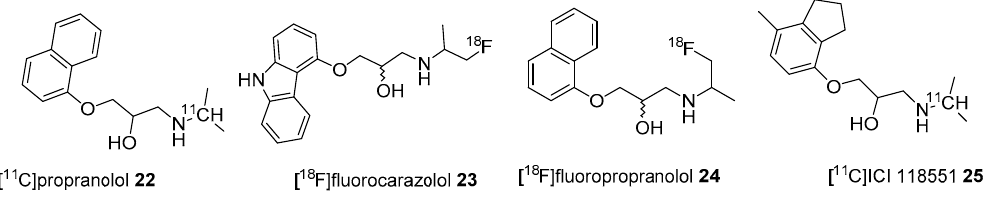
Figure 8. Early PET radiotracers for cerebral β -ARs.